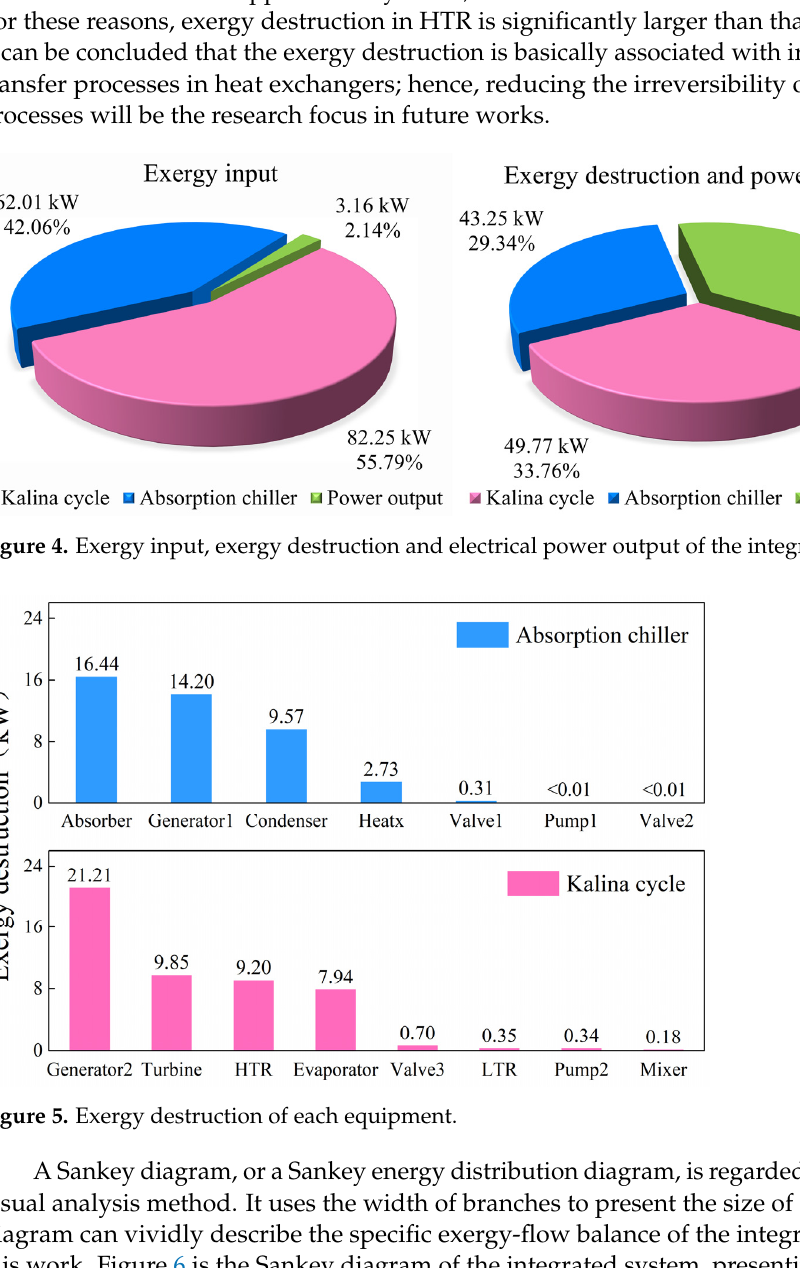
Figure 6. Sankey diagram of the integrated system. 4.2. Advanced Exergy Analysis Results Physical properties, including mass fraction, temperature, pressure, vapor fraction, mass flow rate, mass enthalpy, as well as mass entropy of both the lithium bromide/water solution and ammonia/water solution, are obtained in the process simulation. Detailed simulation results of each stream in the real, unavoidable and ideal cycles are given in Supplementary Table S1–Table S3. Mass concentrations of these two basic solutions are kept the same (55.5% for the LiBr/H 2 O solution and 70% for the ammonia solution). As the integrated system operates in the real, unavoidable and ideal conditions, working flu- ids have totally different mass concentrations. In the absorption refrigeration cycle, the strong solution has the highest mass fraction of 69% when the system operates in the ideal